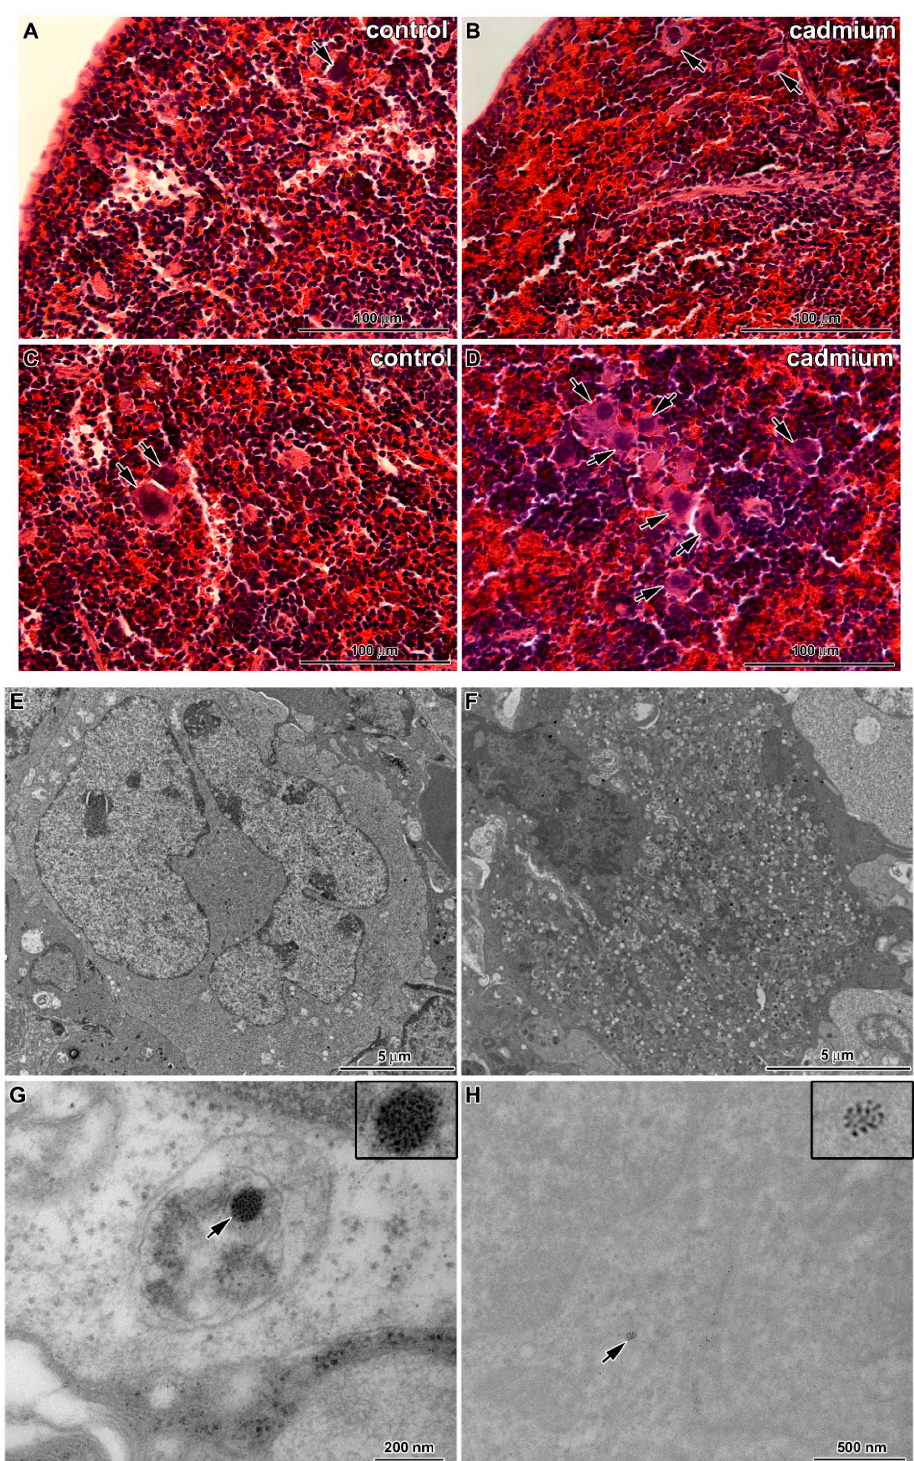
(bb) signs of brush border, arrows show secondary lysosomes with dense granular content without kidney medulla of cadmium treated animal (Hematoxylin-Eosin); and ( K , L ) cadmium nanoparticles (arrows) freely in epithelial cell cytoplasm of proximal tubules. Scale bar A,B,E,F,I,J = 100 µm.